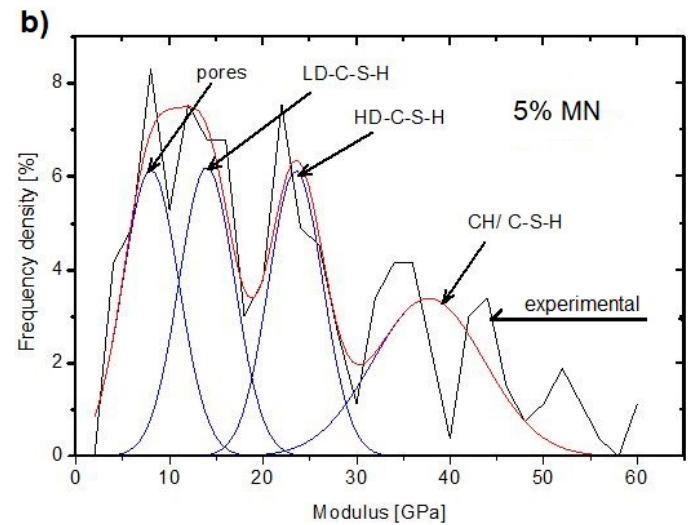
Figure 14. The experimental and theoretical probability distribution of the indentation modulus: ( a ) reference sample (0% nano-Fe 3 O 4 /SiO 2 ) and ( b ) 5% of nano-Fe 3 O 4 /SiO 2 (Reprinted with permission from [83]. Copyright 2017 Elsevier). LD, low density; HD, high density; CH, calcium hydroxide.